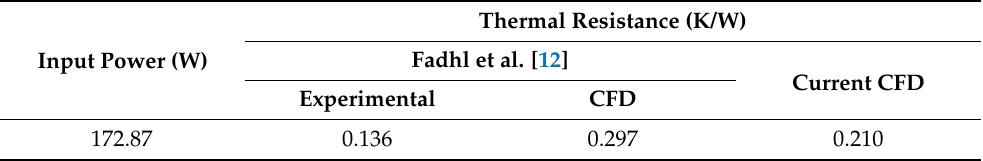
Table 4. Comparison of thermal resistance for validation.